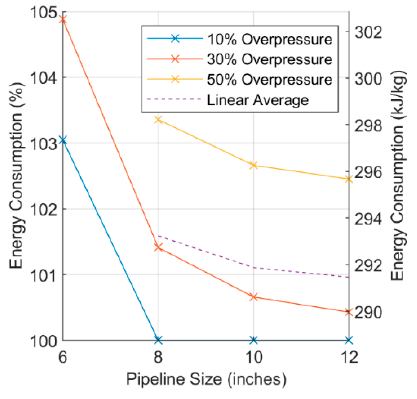
Figure 8. Summary of Energy Consumption for the Melkøya CO2 Pipeline Example.